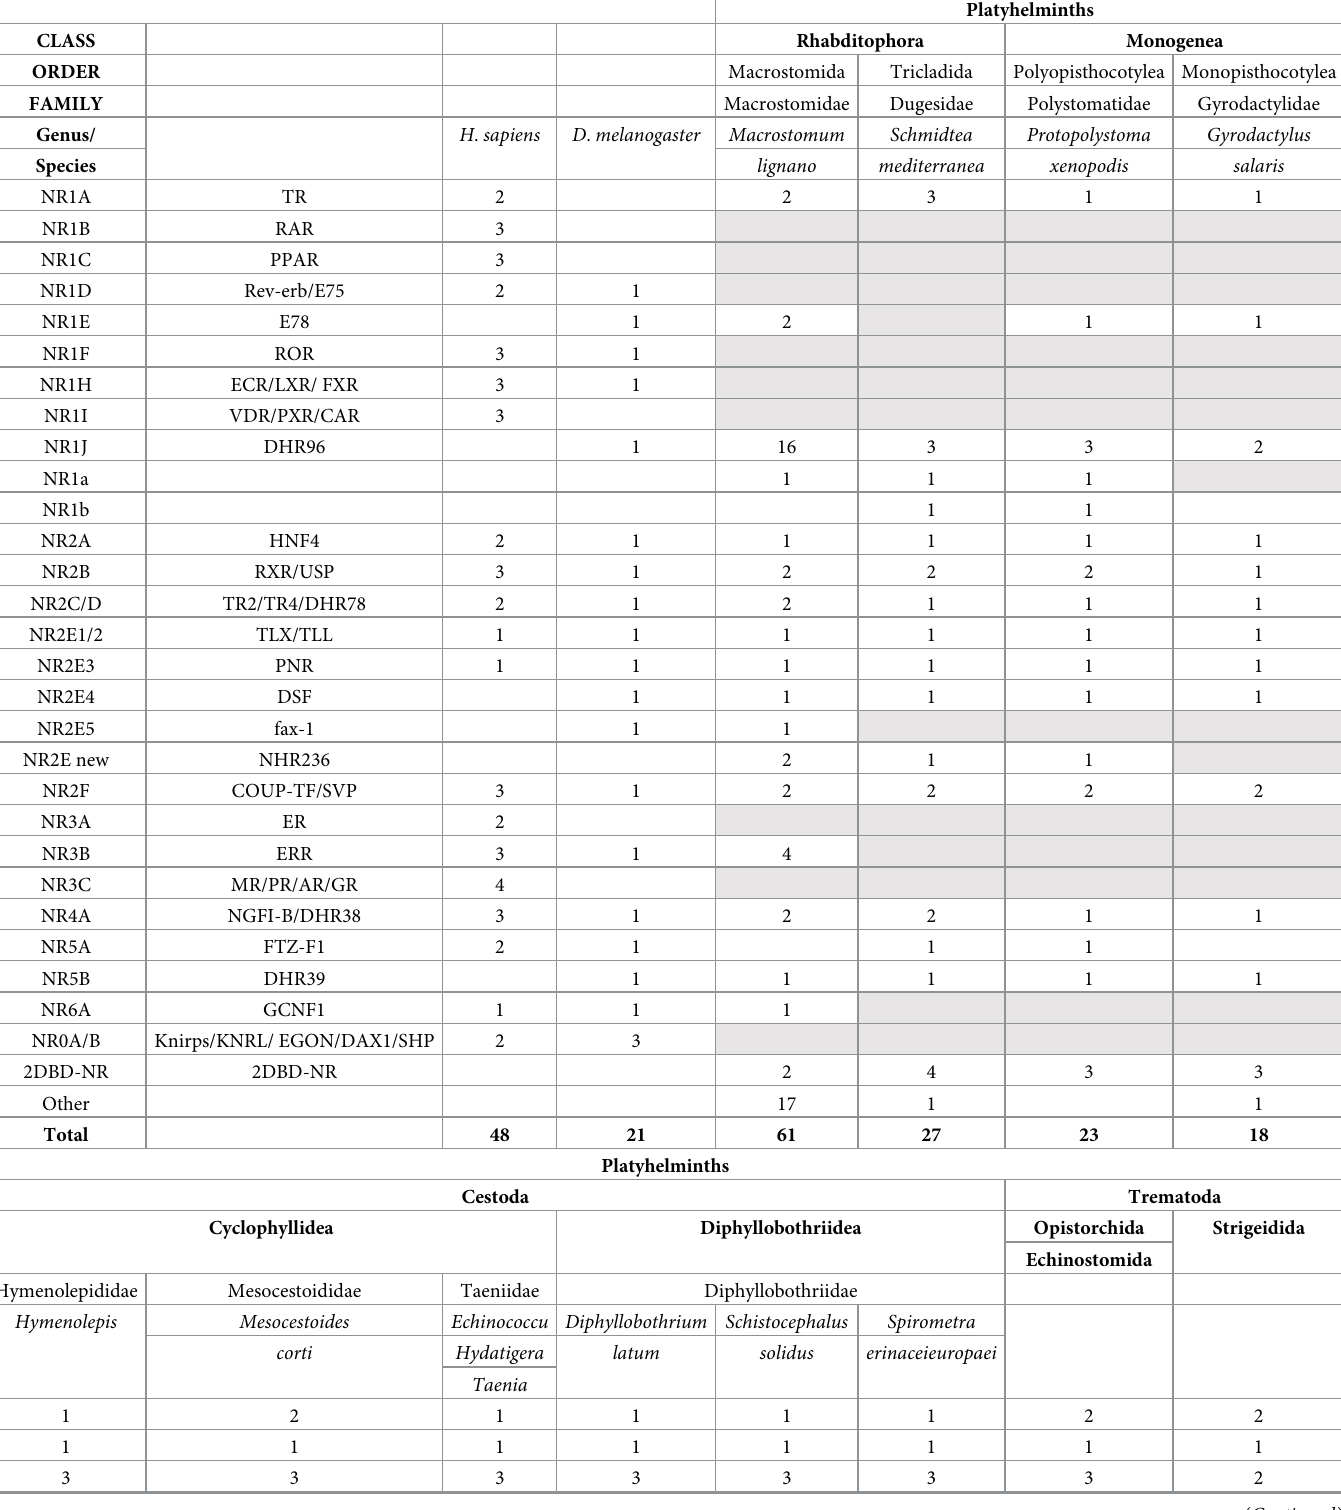
Table 2. Nuclear receptors identified in